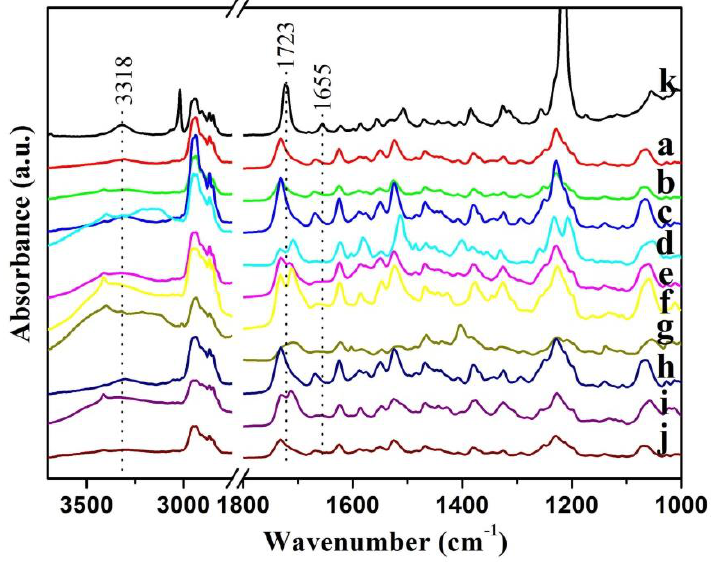
Figure 4. FT-IR spectra of CH-PY in c xerogels ( a – j ): n-butanol, n-pentanol, isopentanol, isooctanol, cyclopentanone, cyclohexanone, nitrobenzene, n-butyl acrylate, THF, DMF, respectively, and in chloroform solution (k).